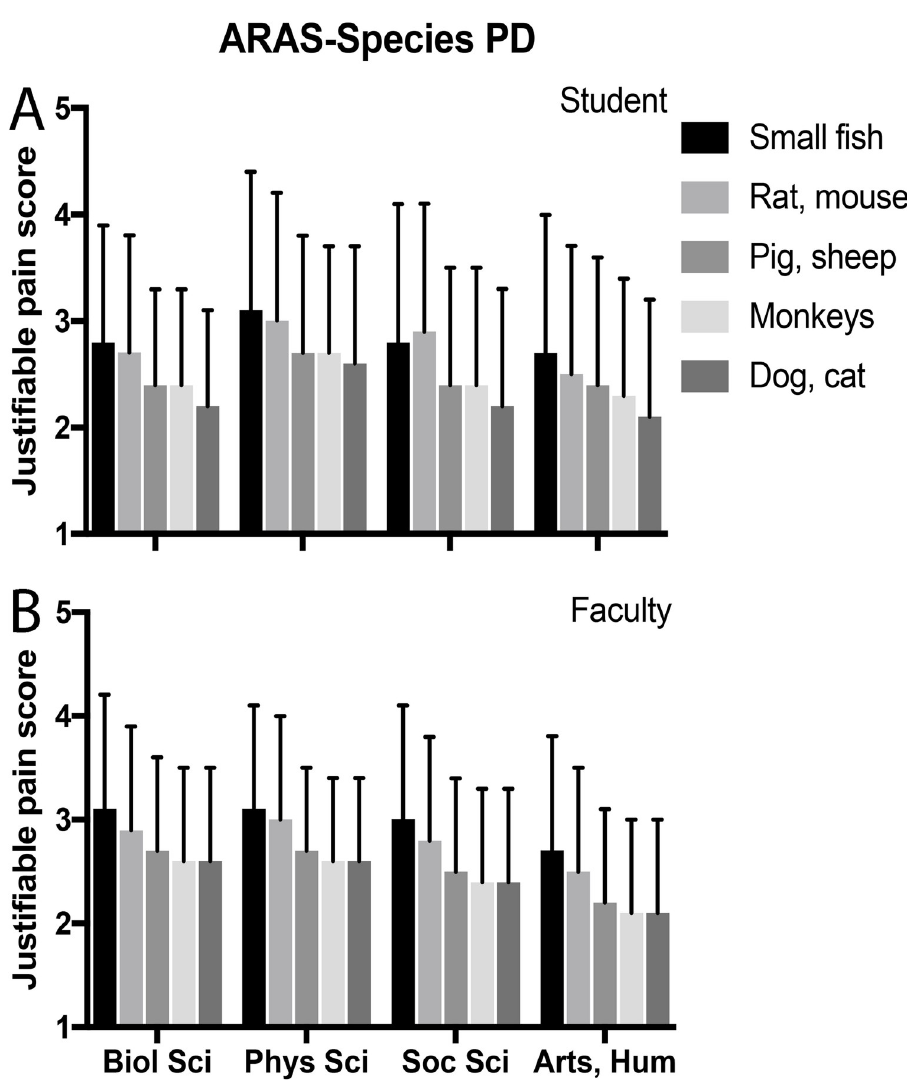
Fig 2. ARAS-species PD score versus discipline.